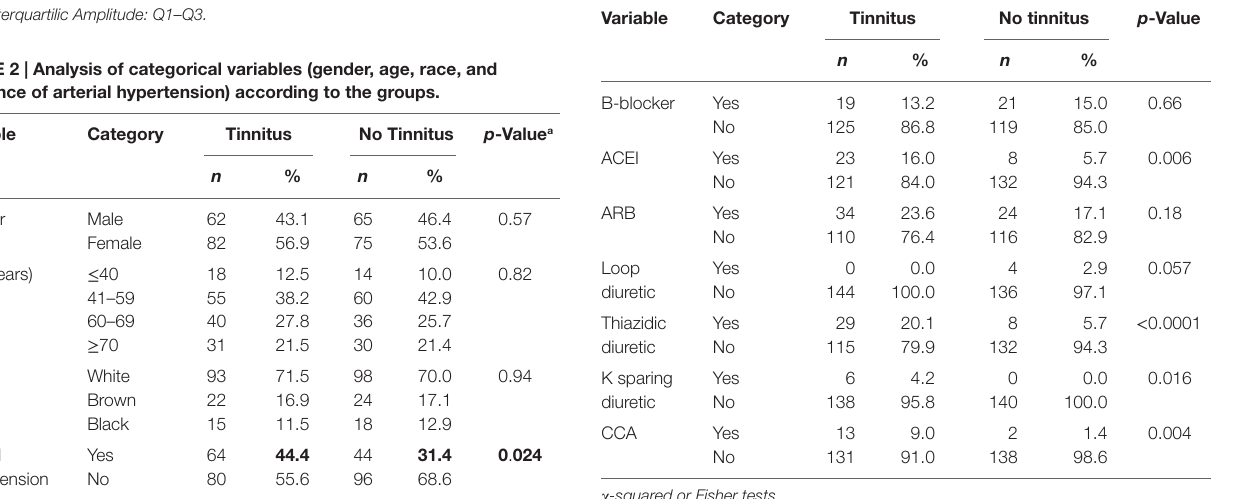
Table 4 | analysis of the categorical variable – antihypertensive drugs used according to the